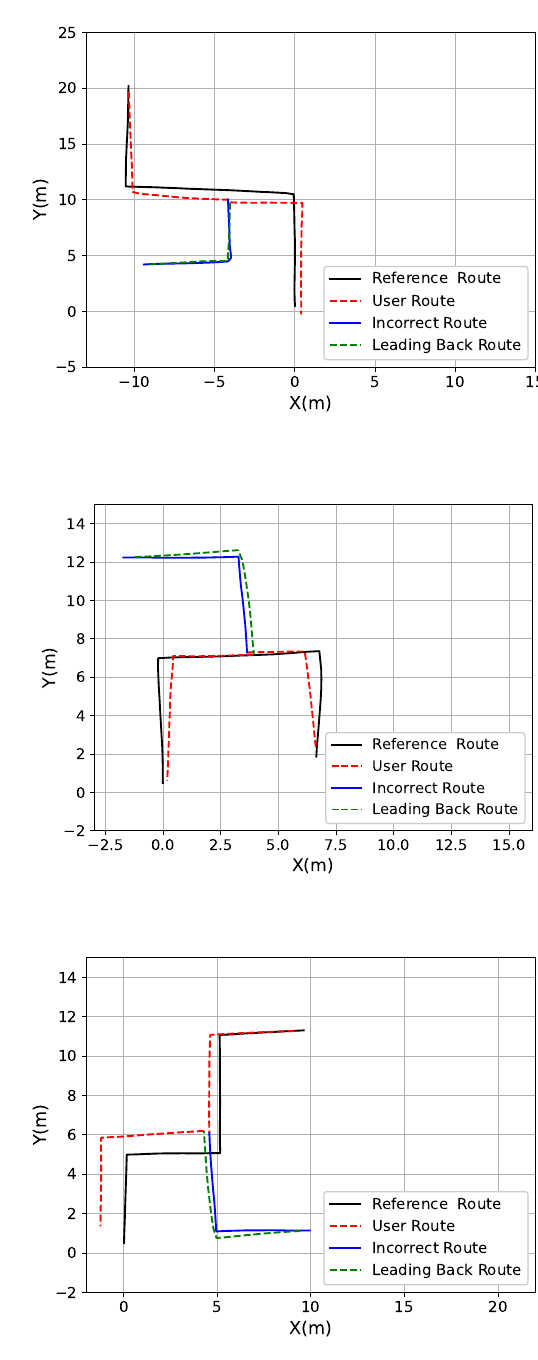
Figure 18. Route map of indoor navigation with leading back. The black solid line represents the reference route, the red dotted line represents the navigation route, the blue solid line represents the incorrect route, and the dotted green line represents the leading back